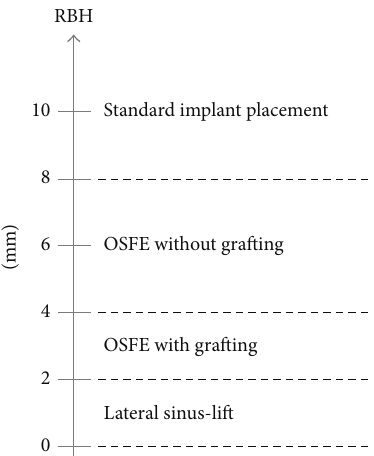
Figure 3: New concept for the management of the posterior maxilla using 8 mm tapered implants. The use of OSFE in patients with a maxillary RBH > 2mm is facilitated by placing tapered implants with a reduced thread pitch. The lateral sinus-lift procedure, with delayed implant placement, is indicated when primary stability cannot be reached with OSFE and when a large amount of bone gain is